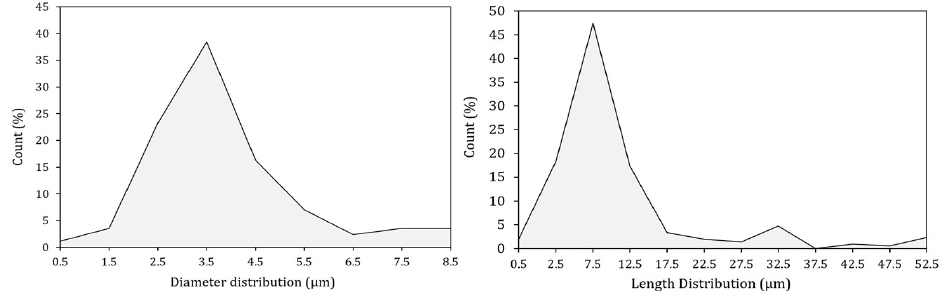
Figure 3. Dimensional analysis of shell powder.